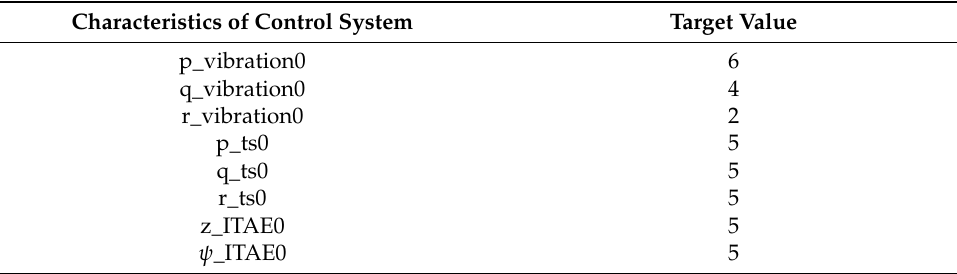
Table A2. Target performance of control